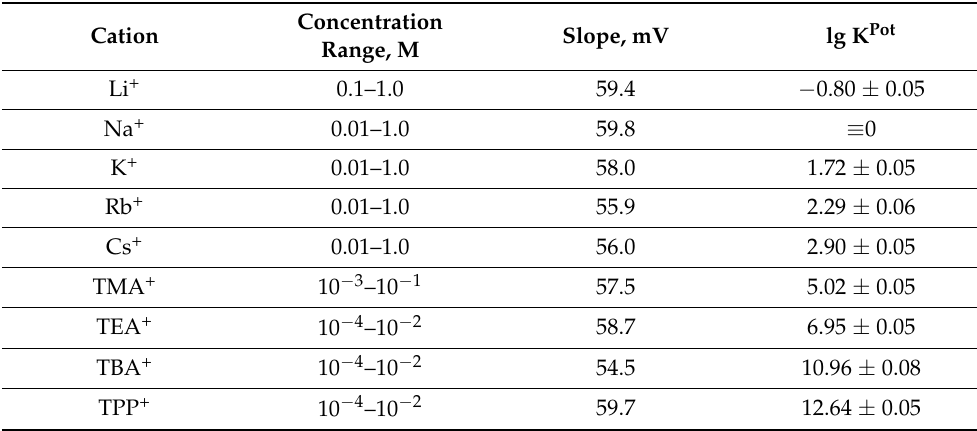
Table A6. The selectivity coefficients for cations (primary ion is sodium cation), slopes, and concen- tration ranges studied.